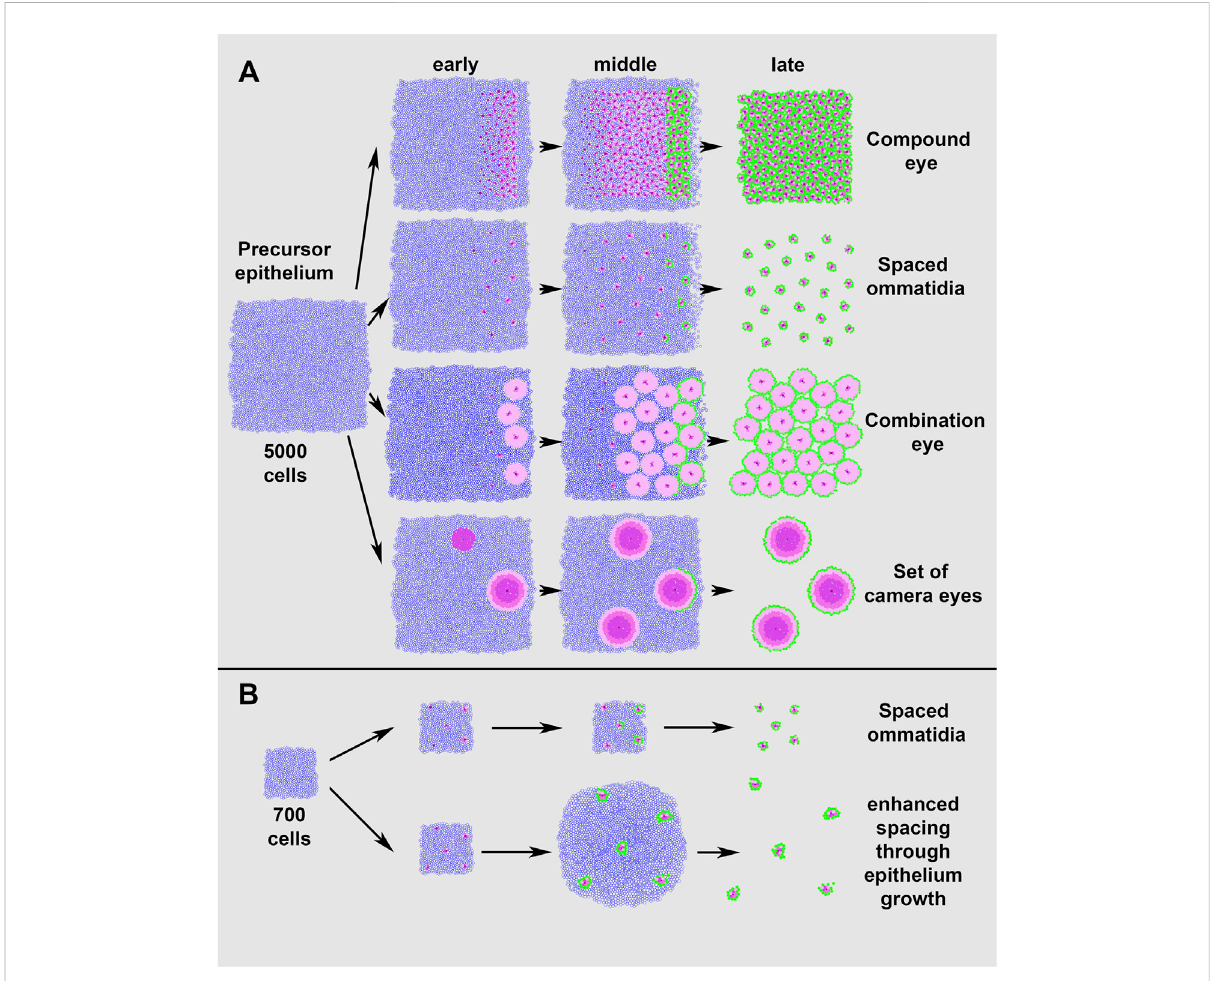
FIGURE 5 Simulations of differenteye layouts fromasingle precursorepithelium.Adjusting onlyafewoftheinput parametersallows EyeVolve to achieve very different eye layouts. (A) . Simulation of eye layouts from a 5,000 cell epithelium. The top row represents the typical ommatidial layout of a compound eye, with cell differentiation starting at the posterior edge and progressing anteriorly. In the second row, the ommatidial units are the same but spaced further apart, as achieved by simply increasing the “ r8 exclusion radius ” from 3 to 10. The third row demonstrates how the addition of photoreceptors (in this case, “ r1, r6 selection count ” was increased from 2 to 100) leads to the development of an eye that combines the optical features of compound eyes and image-forming lens eyes. The fi nal row shows how a set of camera-type eyes might develop in a similar manner with a few additional changes, such as seeding R8 cells at a larger distance but further from the edge, increasing the number of photoreceptors (R2 – R6-likecells),allowingfor alarger recruitmentdistance from R8,and increasing thedistance from thefurrowfor each step. (B) . Simulation ofeyelayouts froma700 cellepithelium.The toprow representstheommatidial layout obtained byreducingtheepithelium startingsize and decreasing the “ min distance from edge ” (from 8 to 3), as compared to the spaced ommatidial layout in (A) . The bottom row illustrates that delayed cell death ( “ distance from furrow ” increased from 1,000 to 100,000) results in enhanced spacing after cell speci fi